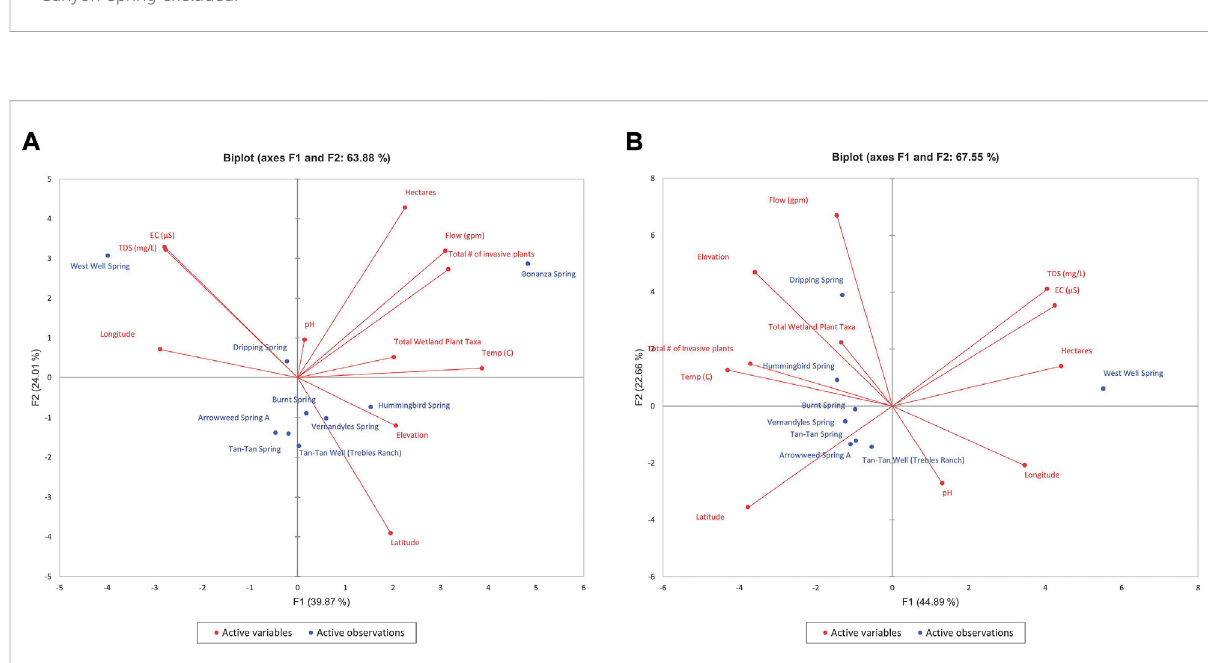
FIGURE 7 PCA biplot of F1 and F2 for ecohydrological dataset for the South Central Desert region (A) Moronga Canyon Spring included, (B) Moronga Canyon Spring excluded.